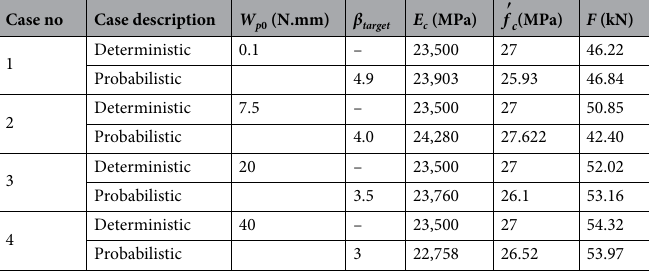
Table 1. Deterministic and probabilistic